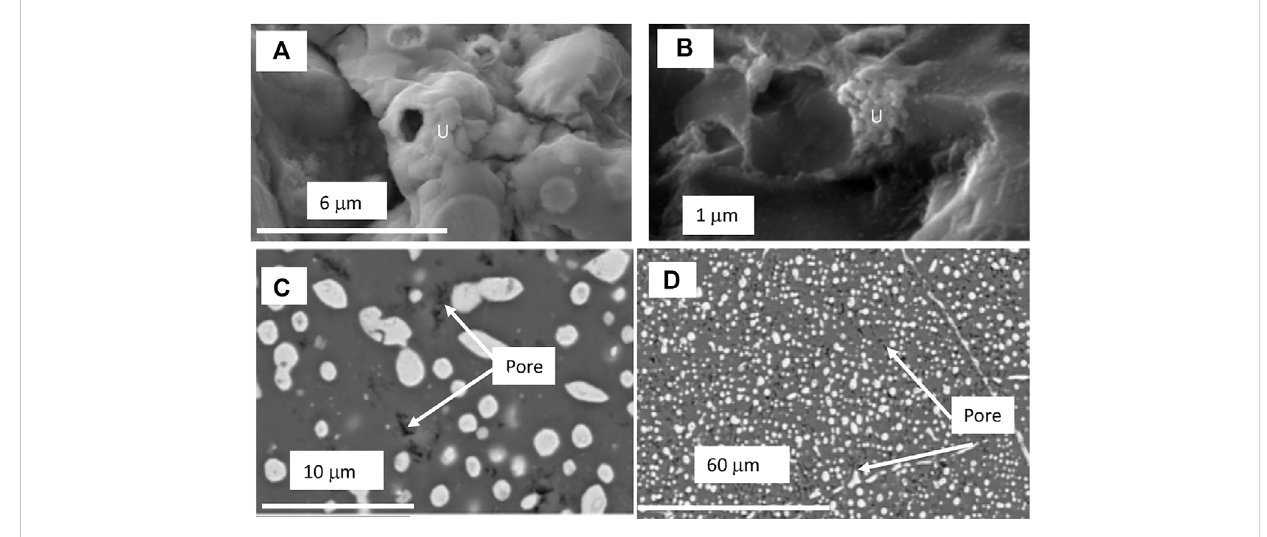
BSE images (A,B) showing fracture surfaces in the fuel pellet that expose the U-rich fuel phase that appears to be fi ne-grained with evidence of porosity. Porosity in the ZrH matrix can be seen in the images presented in (C) and (D)